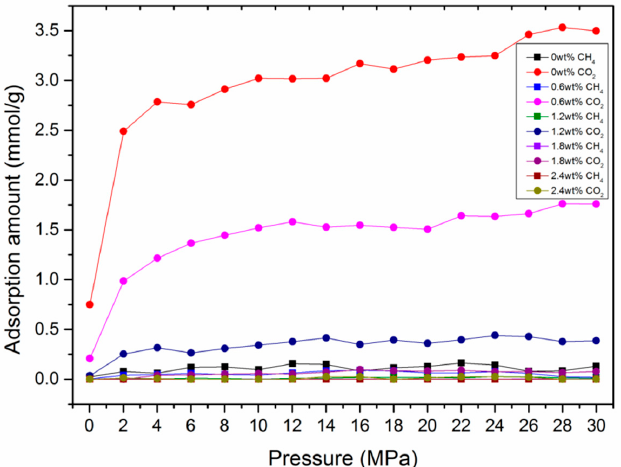
Figure 8. The adsorption amounts of CH 4 and CO 2 with pressure in type I-A kerogen at different moisture contents.